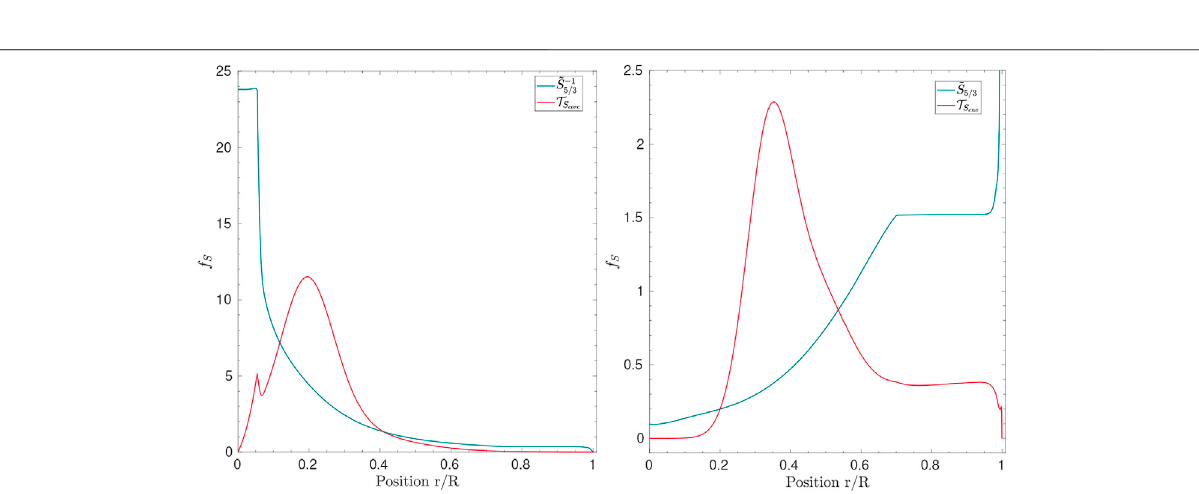
FIGURE 9 | Left : t u inversion results as a function of mean density for 16CygA, using no surface correction (blue) and the Sonoi et al. (2015) correction (green), orange crosses showing the reference values (adapted from Buldgen et al. (2022)). Right : target function for the t u indicator for a model of 16CygA.